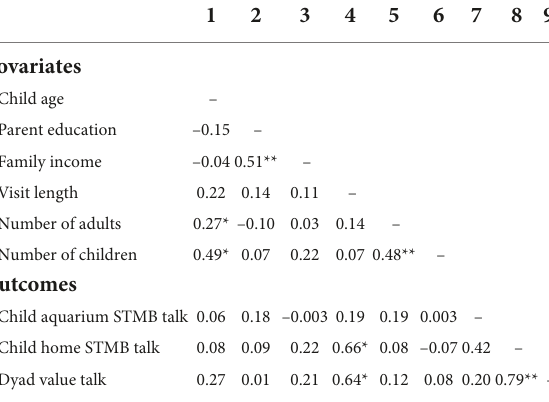
TABLE 2 Bivariate correlations between covariates and outcomes